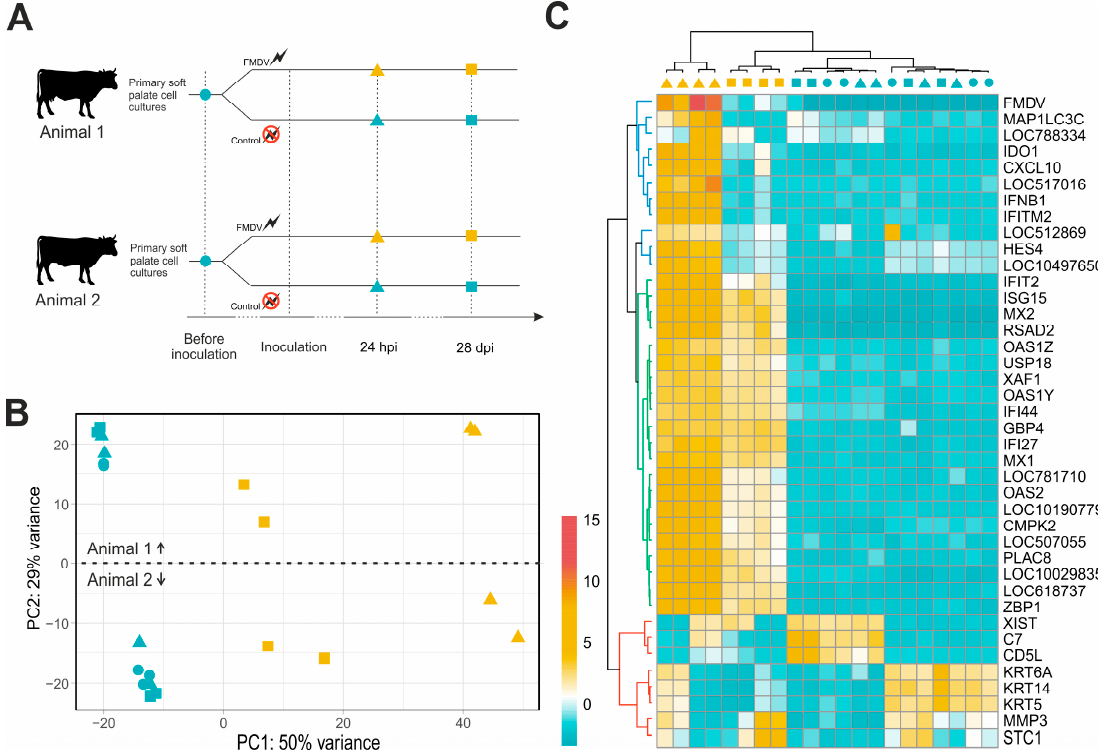
Figure 1. Experimental setup of RNA sequencing and exploratory data analysis. ( A ) Primary soft palate (SP) cell cultures were obtained from two animals. Baseline samples for RNA sequencing were collected immediately before inoculation (circle). Subsequently, the cell cultures were inoculated with foot-and-mouth disease virus (FMDV) (orange symbols) or mock-infected for use as controls (blue symbols). Cells were then harvested for sequencing at 24 hours post infection (hpi) (triangles) or 28 days post infection (dpi) (squares), representing acute and persistent infection, respectively. ( B ) Principal components analysis based on normalized gene counts of the 1000 most variable genes. ( C ) The variance of normalized gene counts was calculated for each gene and the 45 genes with the highest variance were selected and visualized in a heat map. The color of the cells indicates the difference from the mean normalized gene count of the corresponding gene. Samples and genes were clustered according to these differences (trees). The transcript cluster highlighted in green is similarly activated by acute and persistent FMDV infection, while the blue cluster highlights transcripts that are only active during the acute phase of infection. The red cluster comprises transcripts whose abundance differs between donor animals used in this experiment.